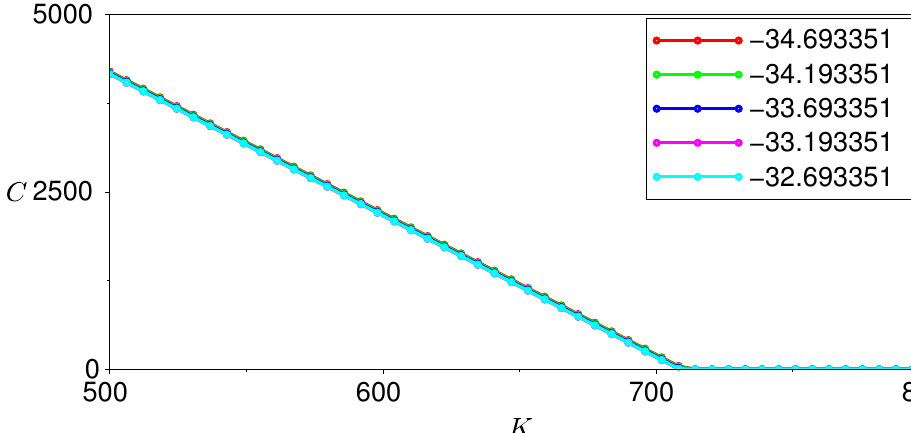
Figure 10. Option prices for varying values of θ 2 .